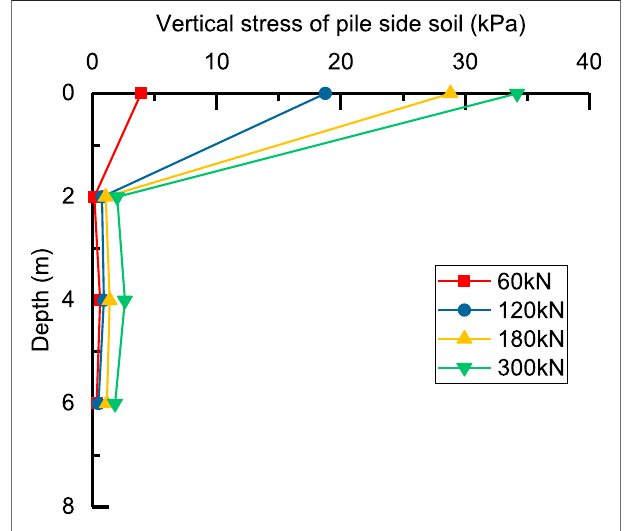
FIGURE 8 | Vertical stress distribution of TCP1 pile side soil along the